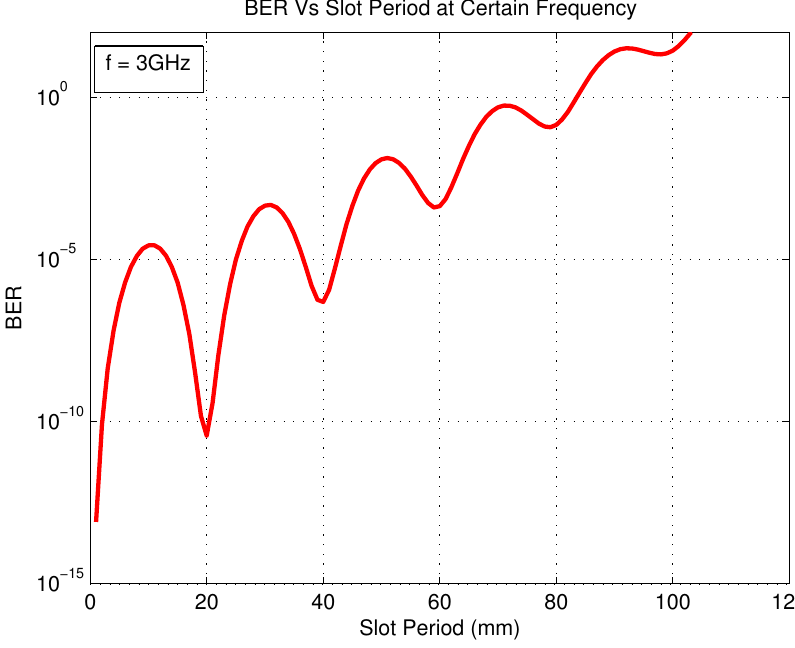
Figure 4. Bit Error Rate vs. the slot period (number of slots) of the leaky feeder.